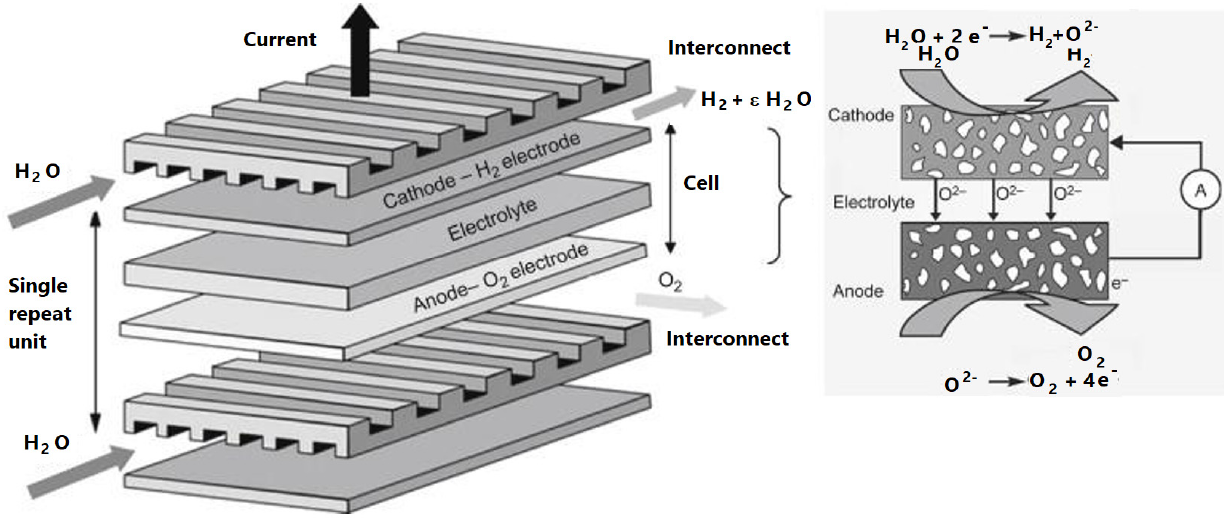
Figure 15. Representation of an electrochemical cell.